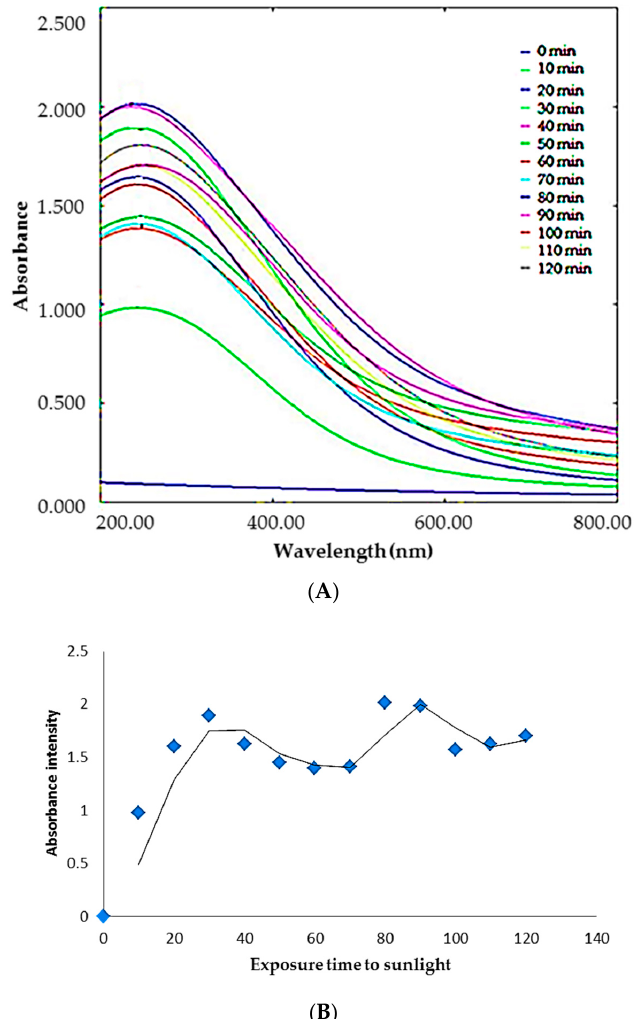
Figure 1. ( A ) UV-visible absorption spectra of synthesized DSAgNPs at different time interval under sunlight, ( B ) Effect of exposure time (min) to sunlight on formation of DSAgNPs.